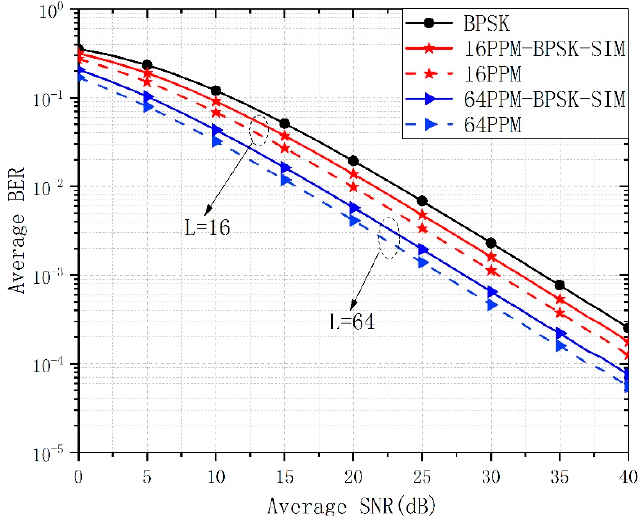
Figure 7. Average BER of hybrid modulation, LPPM, and BPSK against average SNR per hop under strong turbulence and the pointing error parameter is ξ = 1. Turbulence parameters are α = 4.2 and β = 1.4, the constant is assumed to be C = 4.1.